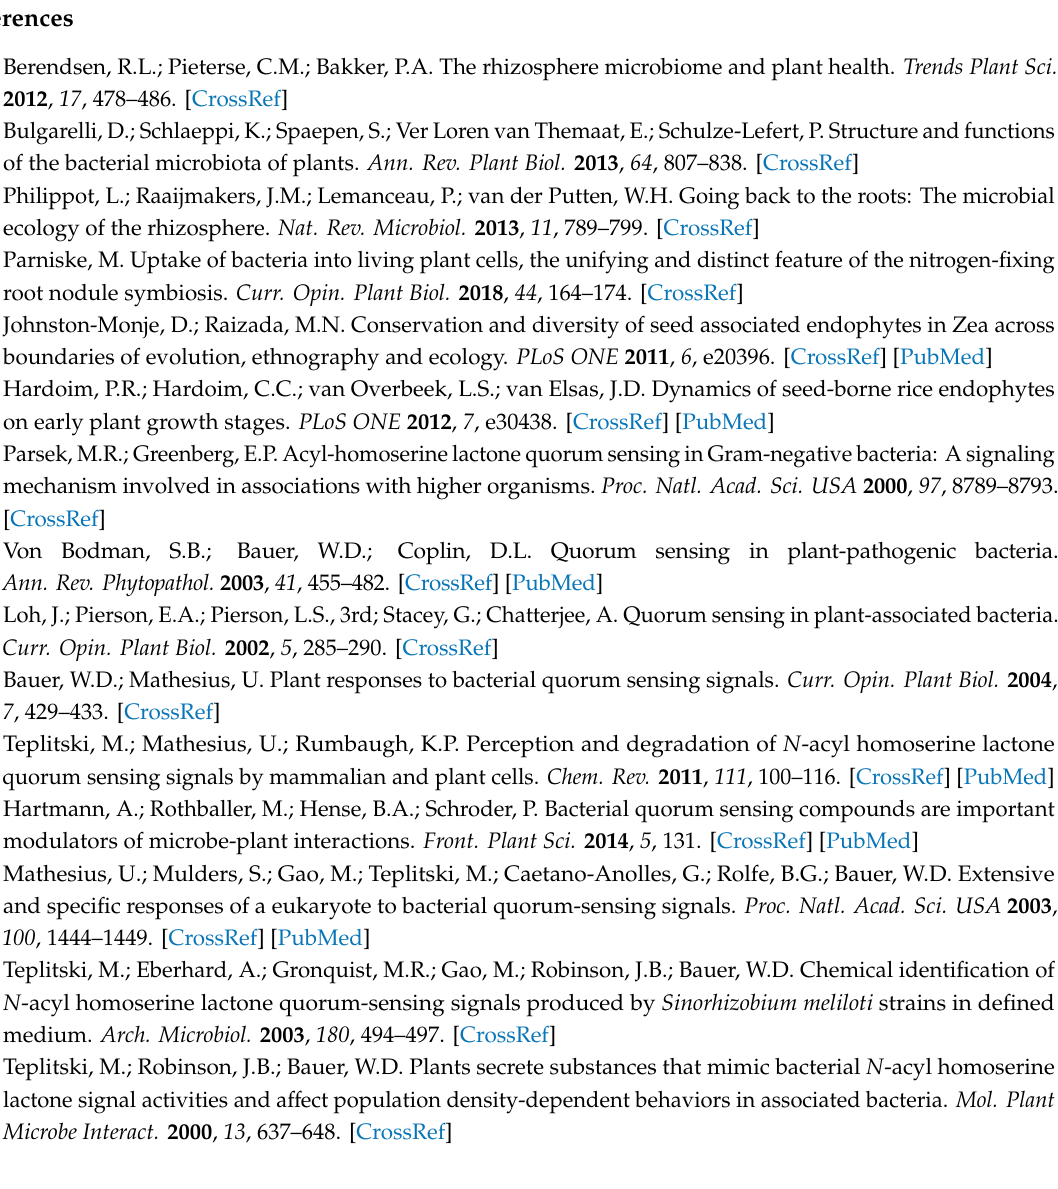
Table S1: OTUs identified from bacterial communities associated with M. truncatula in the absence and presence